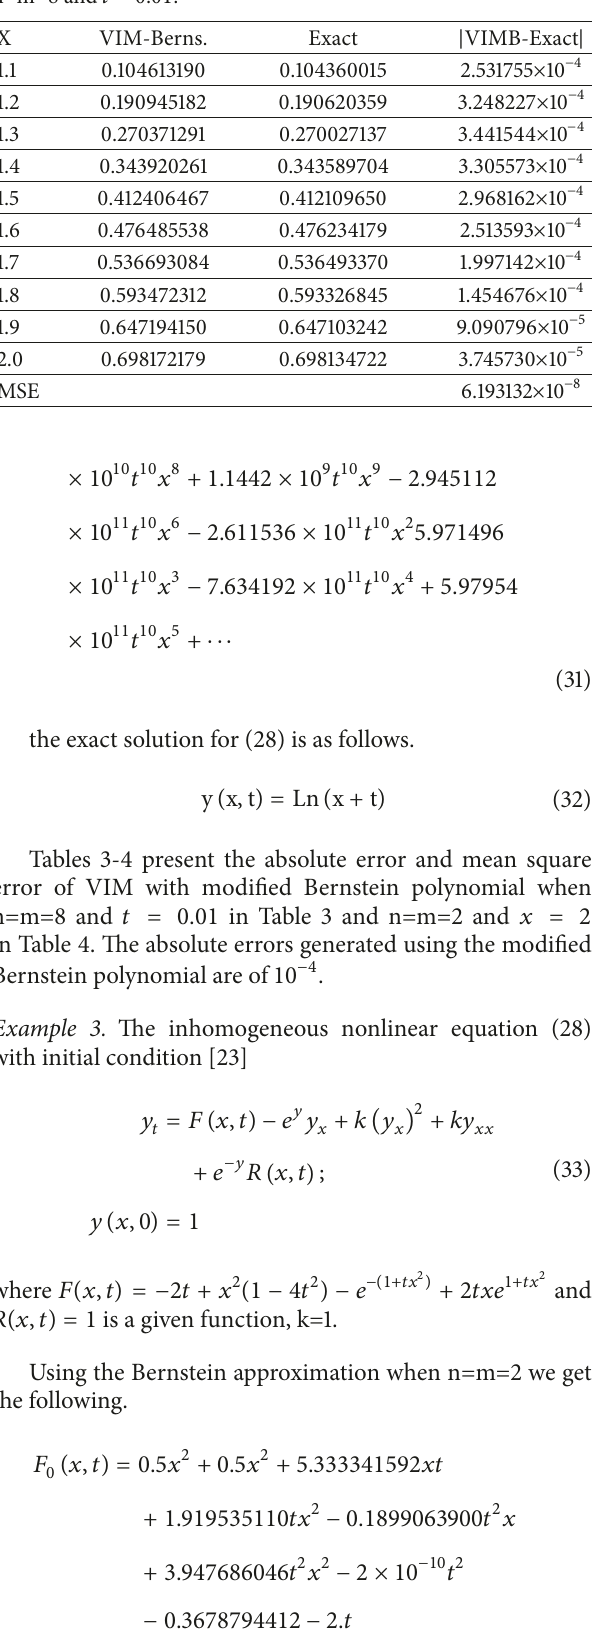
Table 3: The absolute and mean square errors using y 1 for (28) when n=m=8 and 𝑡 = 0.01